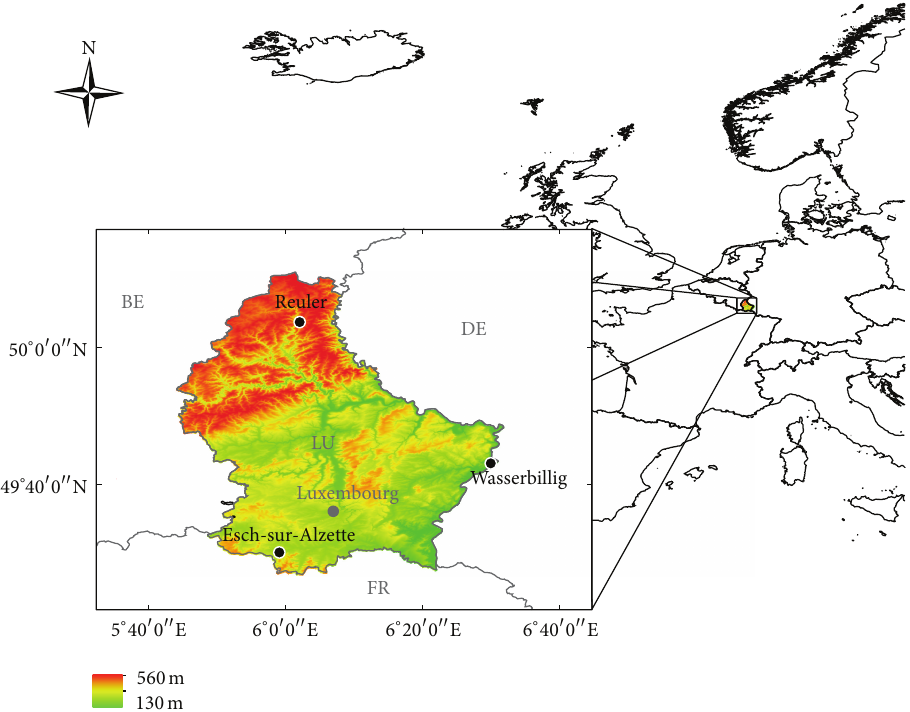
Figure 1: Application domain within Europe (WGS 84). High-resolution model domain in Luxembourg (1.3 km) including topography (m) above mean sea level. Black dots indicate the locations of the pseudo sites extracted from the COSMO-CLM data; the grey dot indicates the multimodel location.